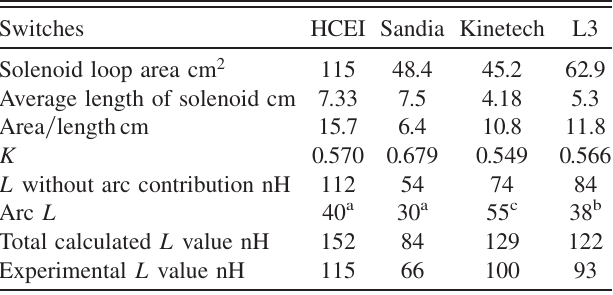
TABLE IV. Calculated and experimentally measured switch